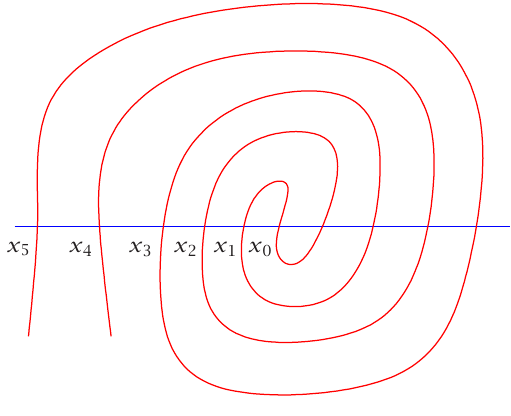
Figure 6.1 . Lunes from x